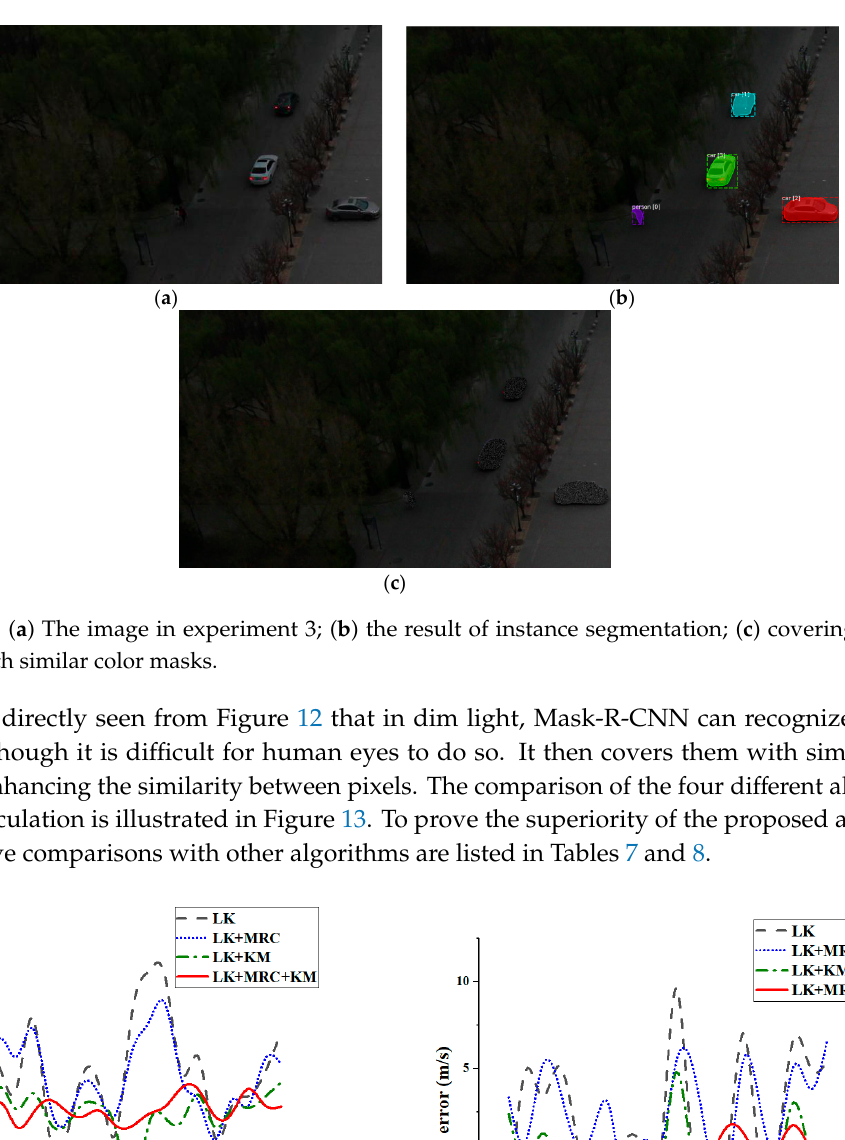
Table 8. Velocity errors of four algorithms in the Y direction. LK